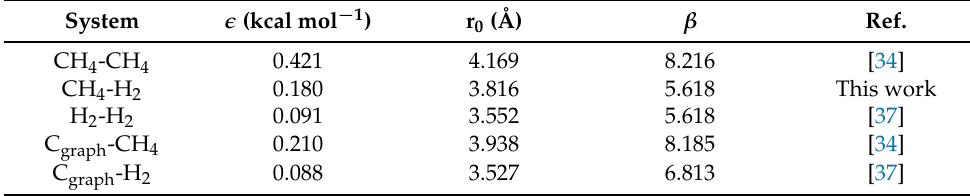
Table 1. The interaction parameters used in this work.